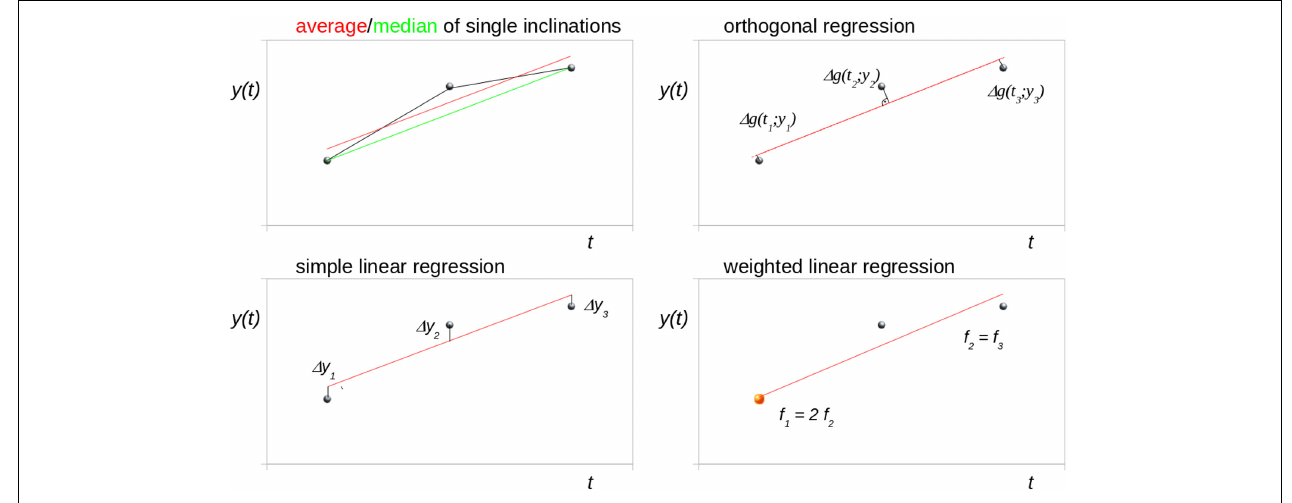
FIGURE 1 | Schematic illustration of different trend analysis approaches for the fit of three data points for identical time intervals (bisectioning the observation time). The central data point was shifted to simulate a disturbance. (cid:49) g denotes the orthogonal distance to the regression